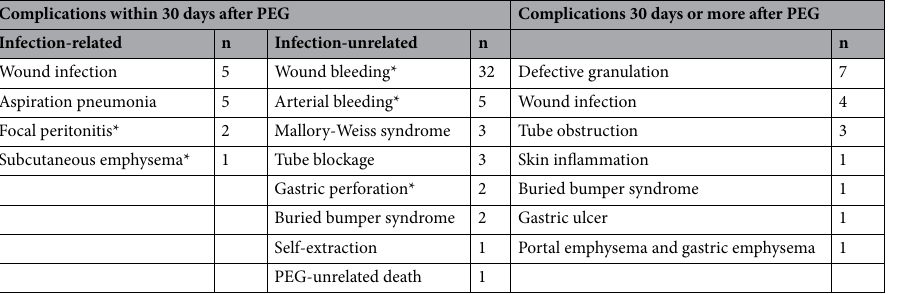
Table 2. Classification of complications (n = 80). PEG percutaneous endoscopic gastrostomy. *Defined as an early acute complication based on a reported definition 5